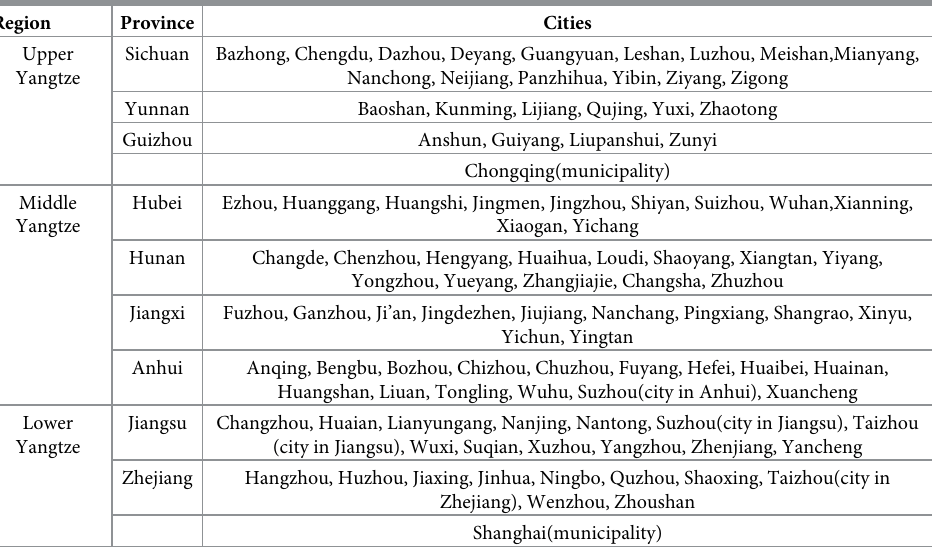
Table 3. Index system of digital finance